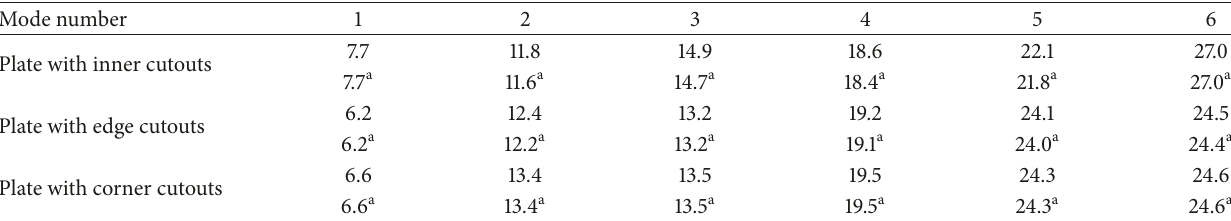
Superscript a indicates the results obtained from